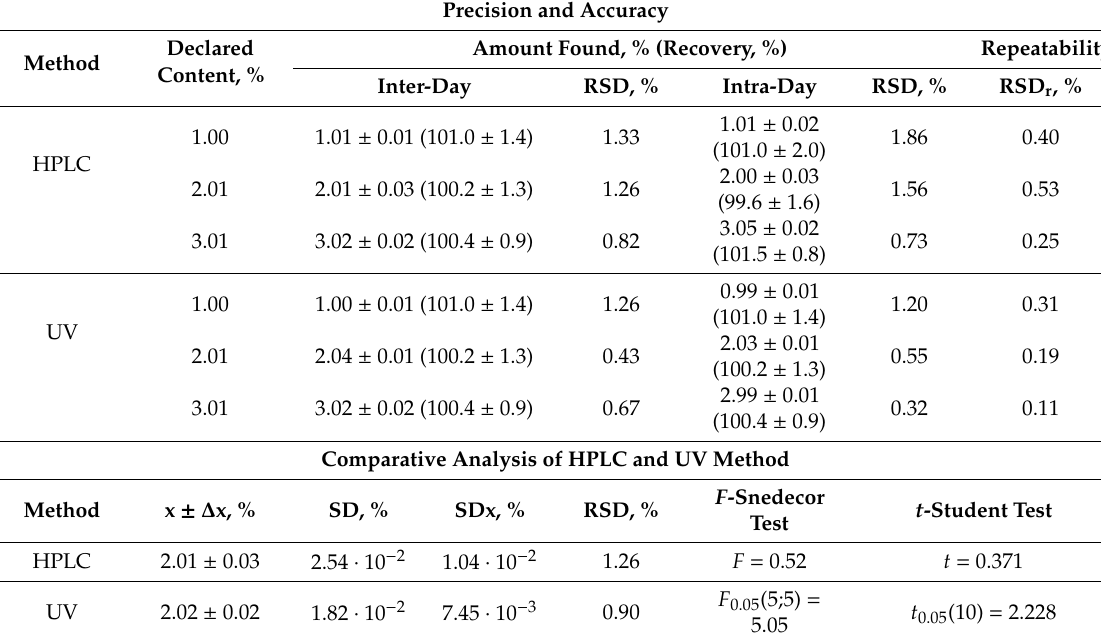
Table 4. The quantitative parameters and statistical data for determination of CS by the proposed HPLC and UV method—validation parameters: precision, accuracy, and comparative